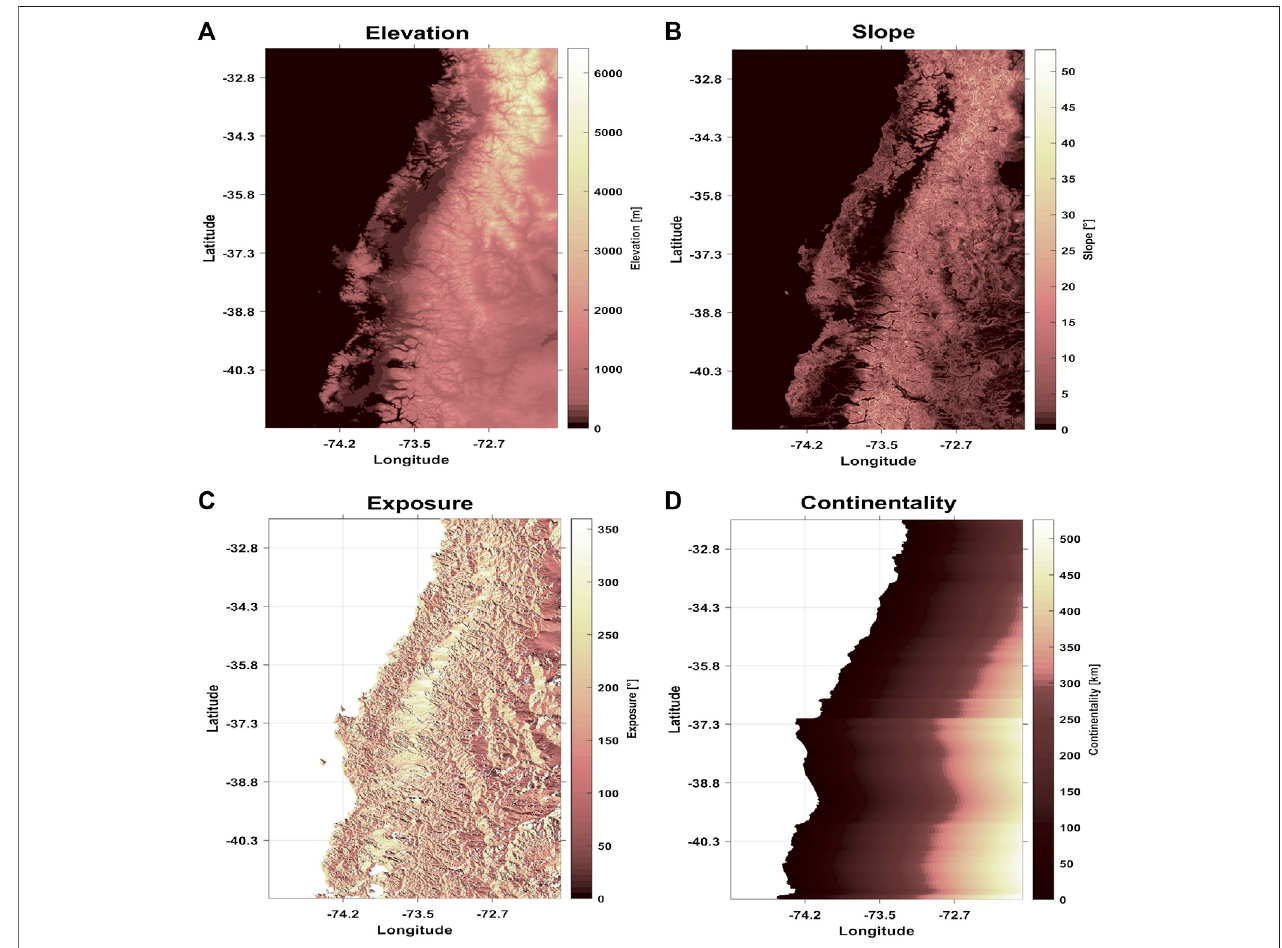
FIGURE 4 | Digital terrain model with independent variables: (A) elevation, (B) slope, (C) exposure, and (D) continentality.